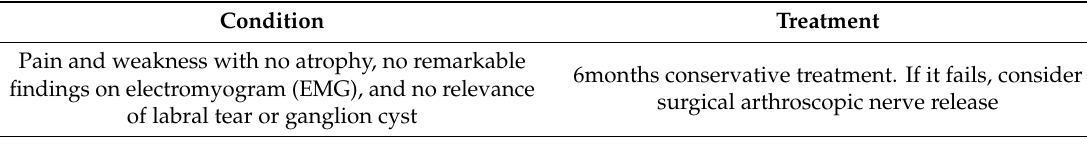
Table 3. Main diagnosis with suggested